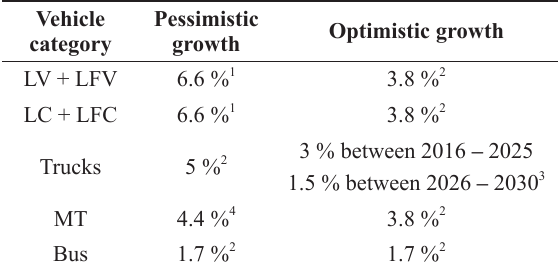
Raise Percentage of the new vehicles licenses by categories between the years 2016 and